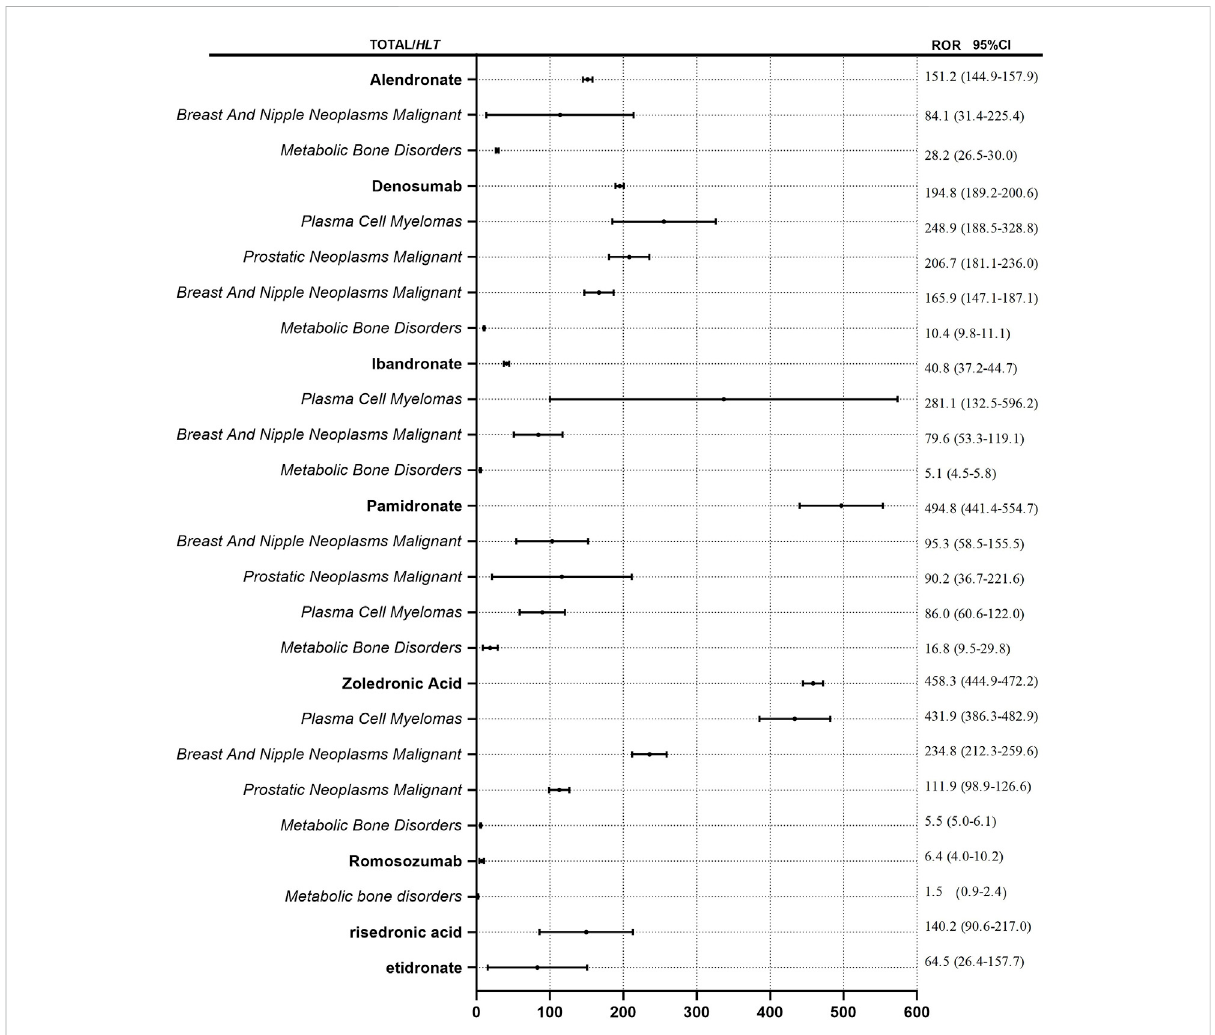
FIGURE 3 ROR for ONJ with antiresorptive drugs. Notes: ROR values for drug names is calculated regardless of indications. ROR values for the italics is calculated by different indications.